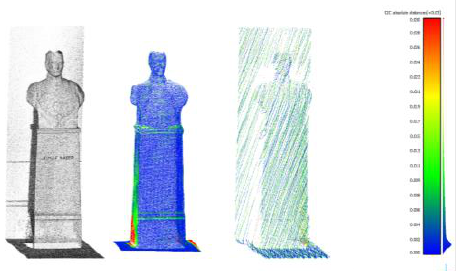
Figure 5 Sculpture point clouds – TLS (left), NavVis (middle), Leica (right)